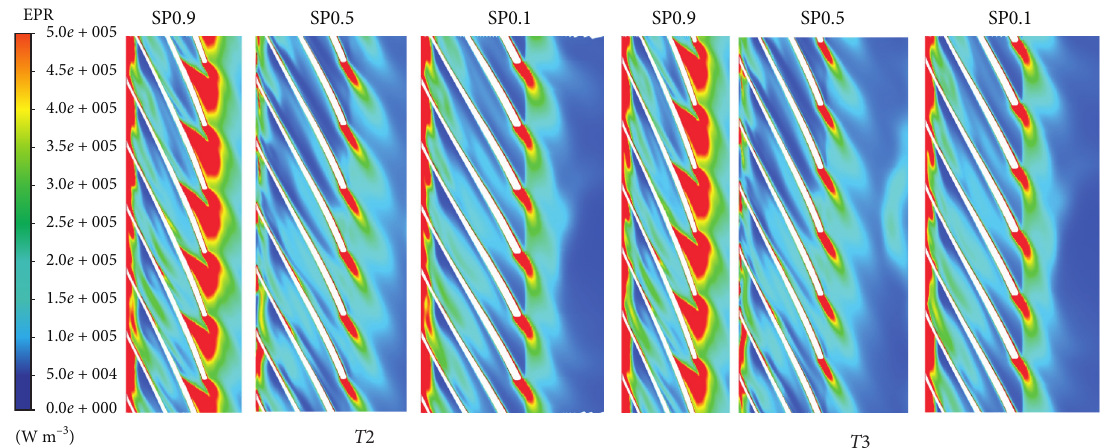
Figure 13: Entropy production distribution in different spanwise surfaces at ( Q ) � 48m 3